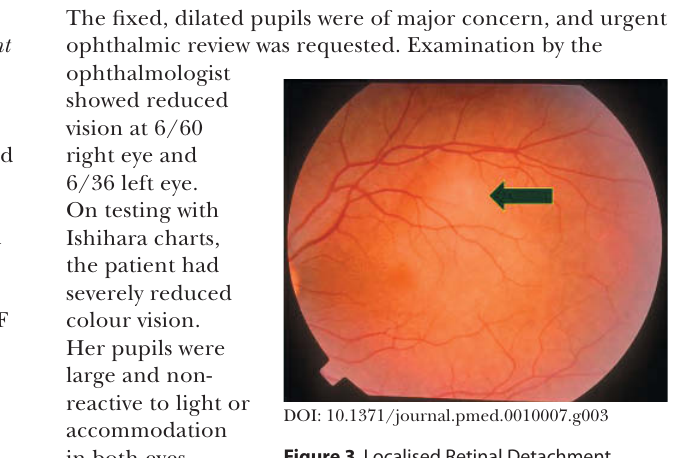
Figure 3. Localised Retinal